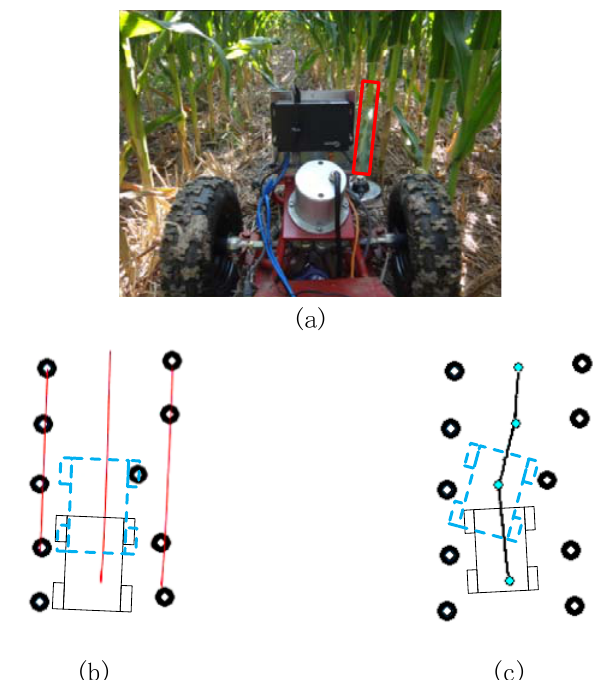
Figure 9. Comparison between centerline extraction method and RBF for crops outside the crop rows, ( a ) experimental scenario; ( b ) result of centerline extraction algorithm; and ( c ) result of RBF.